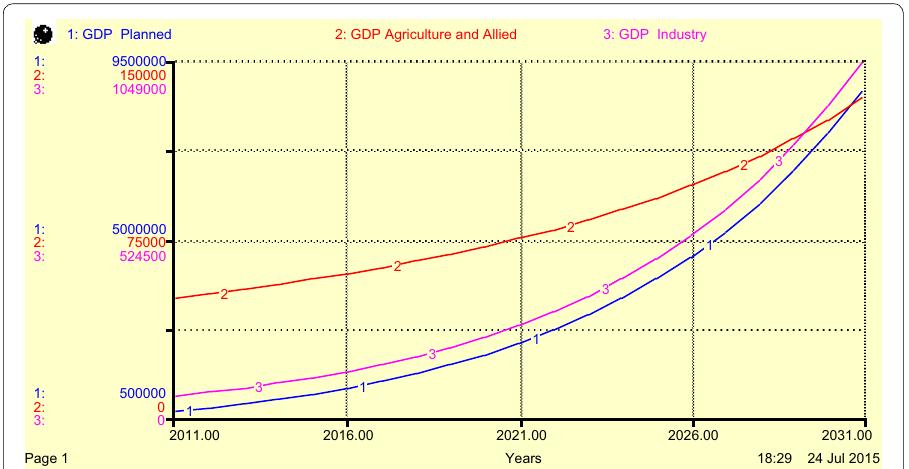
Fig. 21 Perceived projected GDP, GDP in Agriculture and Allied Sector, and GDP in Industrial Sector